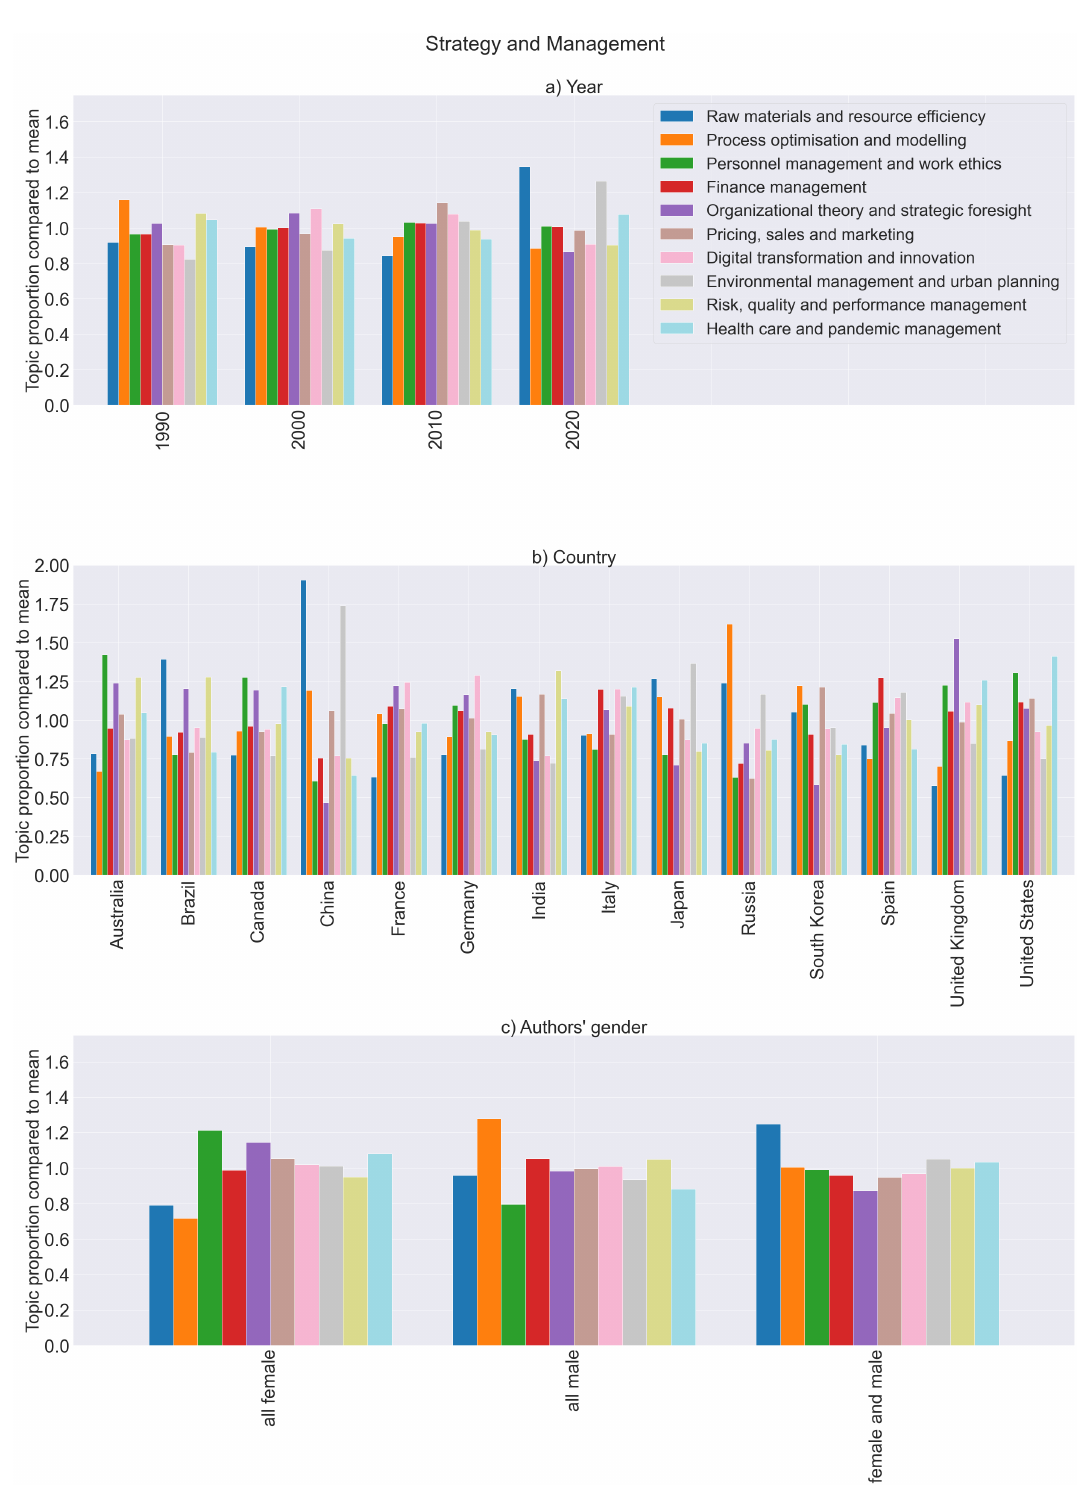
Figure 6. Topic proportion compared to mean, c κ ( ˆ D α ) , for 10 topics of the sub-area strategy and management grouped by ( a ) publication year, ( b ) country, and ( c ) authors’ gender. The legend for the topics and their colour codes at the top right corner applies to all three